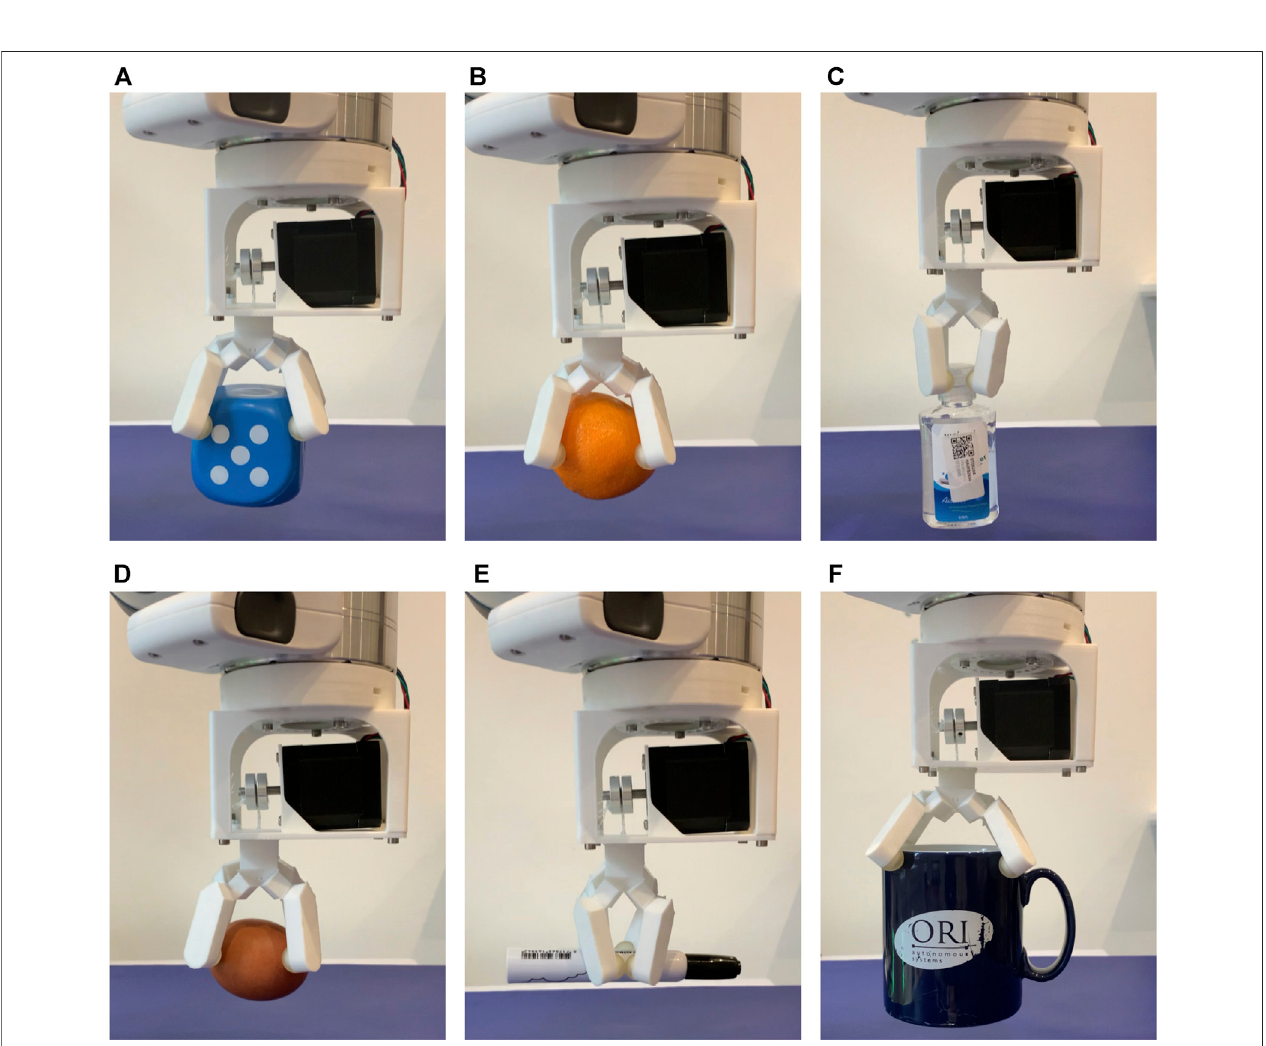
FIGURE 9 | Demonstration of grasping daily objects, which include (A) a dice, (B) an orange, (C) a hand sanitiser, (D) an egg, (E) a marker pen, and (F) a mug with water.